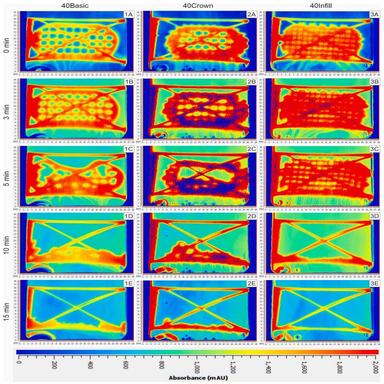
Images of tablets printed from FLU40 (λ = 255 nm).